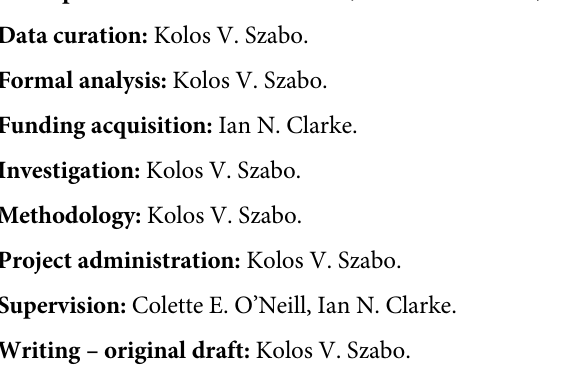
S2 Fig. Maximum-Likelihood estimate for CDS2. Raw unannotated MEGA X data. (TIF) S3 Fig. Maximum-Likelihood estimate for CDS3. Raw unannotated MEGA X data. (TIF) S4 Fig. Maximum-Likelihood estimate for CDS4. Raw unannotated MEGA X data. (TIF) S5 Fig. Maximum-Likelihood estimate for CDS5. Raw unannotated MEGA X data. (TIF) S6 Fig. Maximum-Likelihood estimate for CDS6. Raw unannotated MEGA X data. (TIF) S7 Fig. Maximum-Likelihood estimate for CDS7. Raw unannotated MEGA X data. (TIF) S8 Fig. Maximum-Likelihood estimate for CDS8. Raw unannotated MEGA X data.